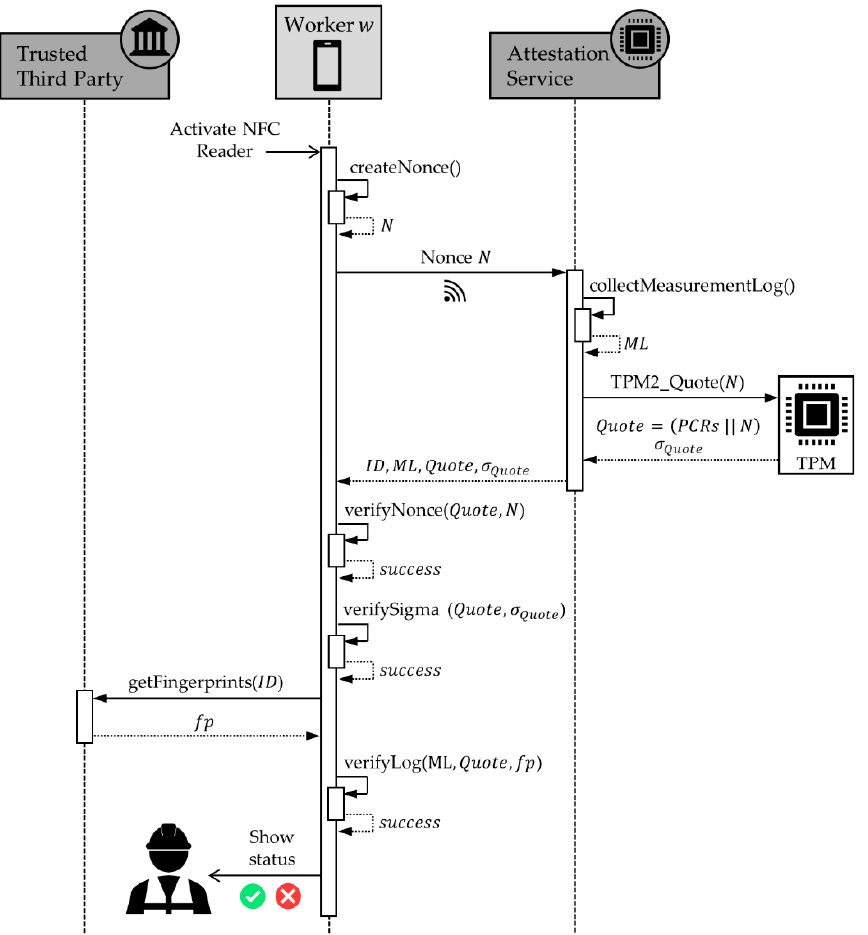
Figure 7. NFC-capable remote attestation protocol integrated into 4Crypt.